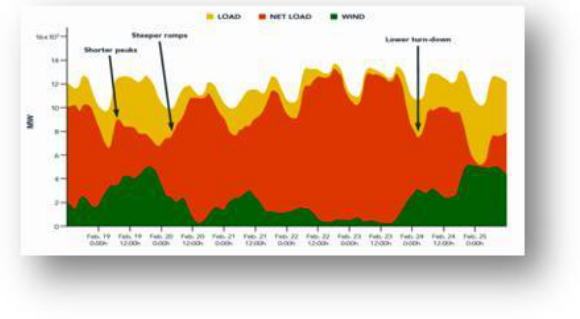
Figure 1. The effect of wind power production in net